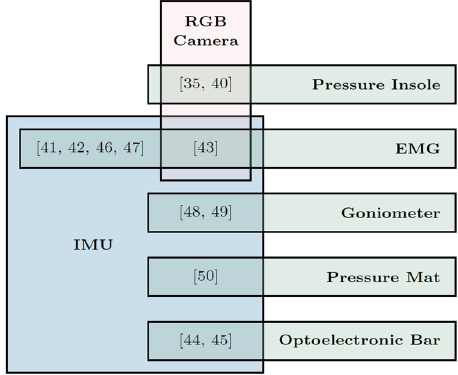
Fig. 3 Studies used multiple sensing modalities. Eleven studies simultaneously used two sensing modalities and one study used three sensing